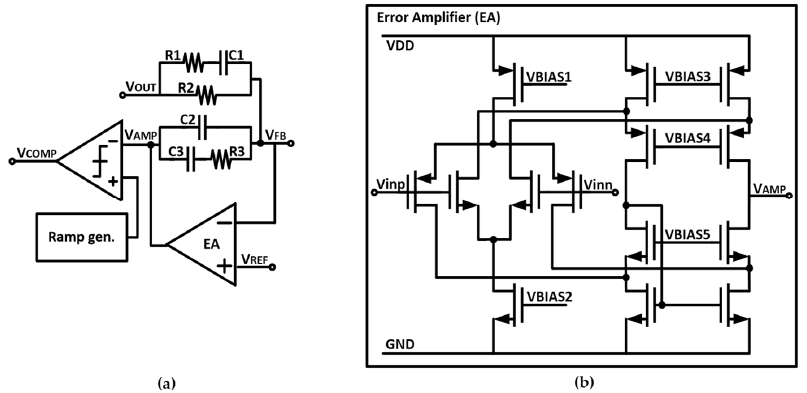
Figure 10. Voltage pulse width modulation (VPWM) controller implementation: ( a ) block diagram of the VPWM controller and ( b ) schematic of constant-transconductance rail-to-rail amplifier.